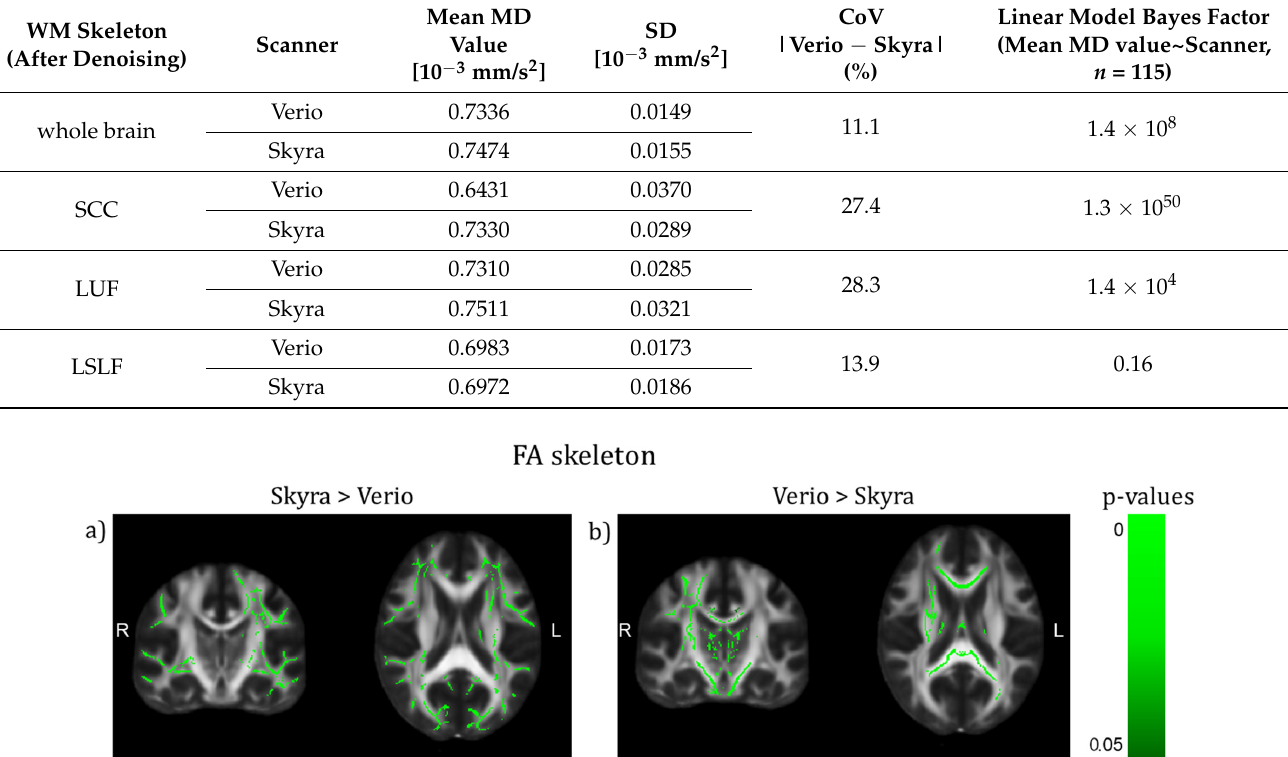
Figure 2. TBSS on the FA skeleton of scanner differences (CMRR sequence) after preprocessing with denoising (TFCE corrected, highlighted tracts: p < 0.05, (y,z) = ( − 18,19)). ( a ) More superficial WM tracts show higher values in Skyra than in Verio. ( b ) Rather deep WM tracts show higher values in Verio than in Skyra.